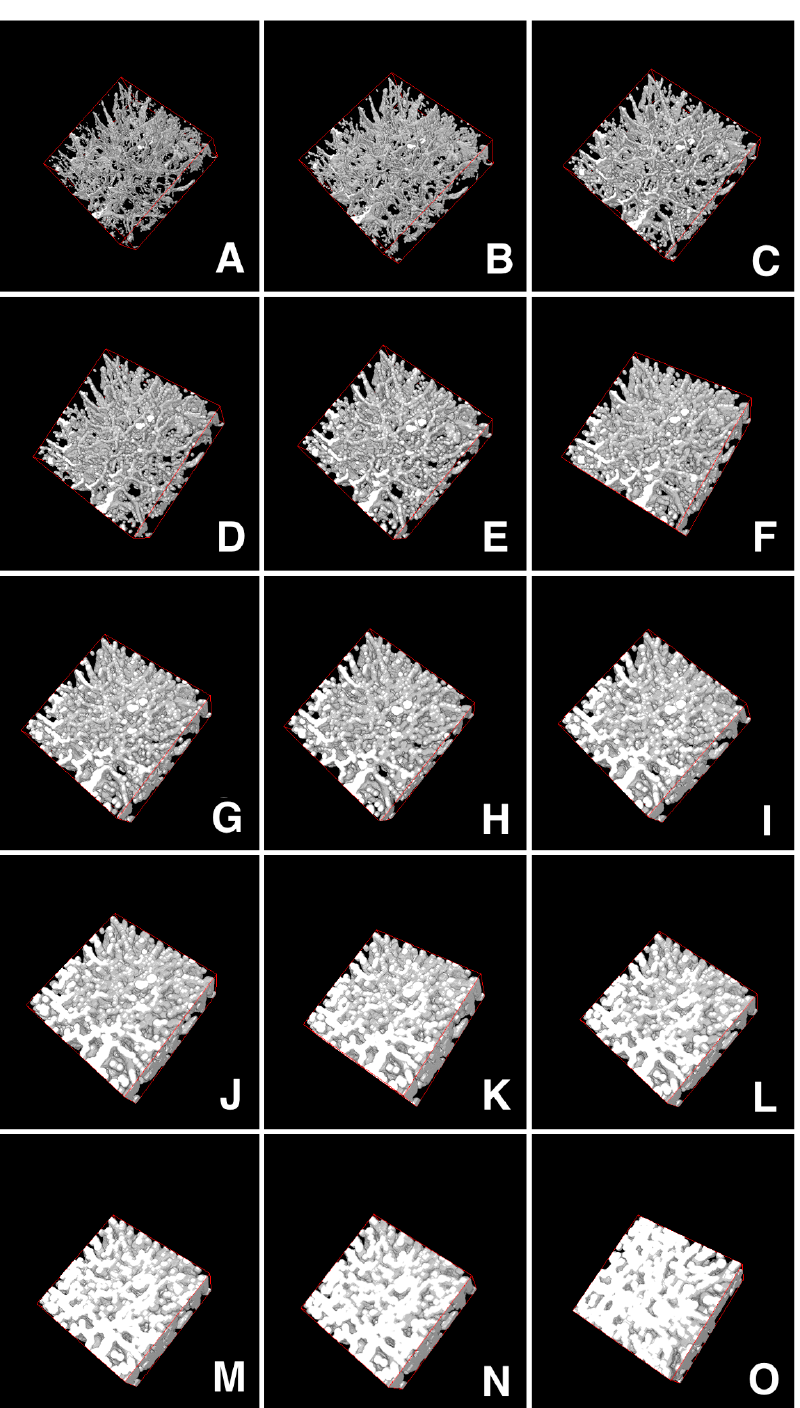
Figure 2. Scheme of microvascular angioarchitecture dilation for the calculus of dispersion in the volume. An initial angioarchitecture is shown by image rendering in panel A . The spatial dispersion of all the vessels is calculated from dilation of the initial image following a rhombicuboctahedral scheme. Panels B – O represent di ff erent steps of dilation until occupancy of at least 95% of the total volume. The total number of single steps needed to reach 95% occupancy is defined as the Hv 95% index. When comparing di ff erent samples, normalization for an equal percent amount of input voxels was performed as described in the Materials and Methods section in order to obtain the final index called nHv 95%